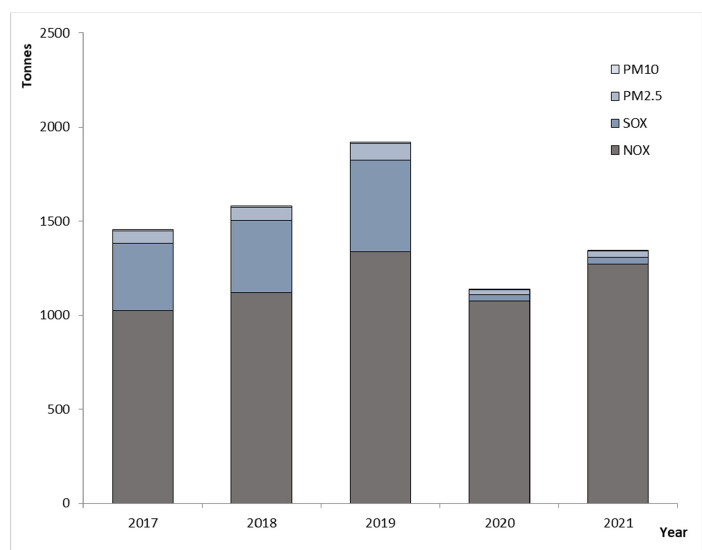
Figure 4. Annual gaseous pollutants emissions for Souda and Heraklion ports.